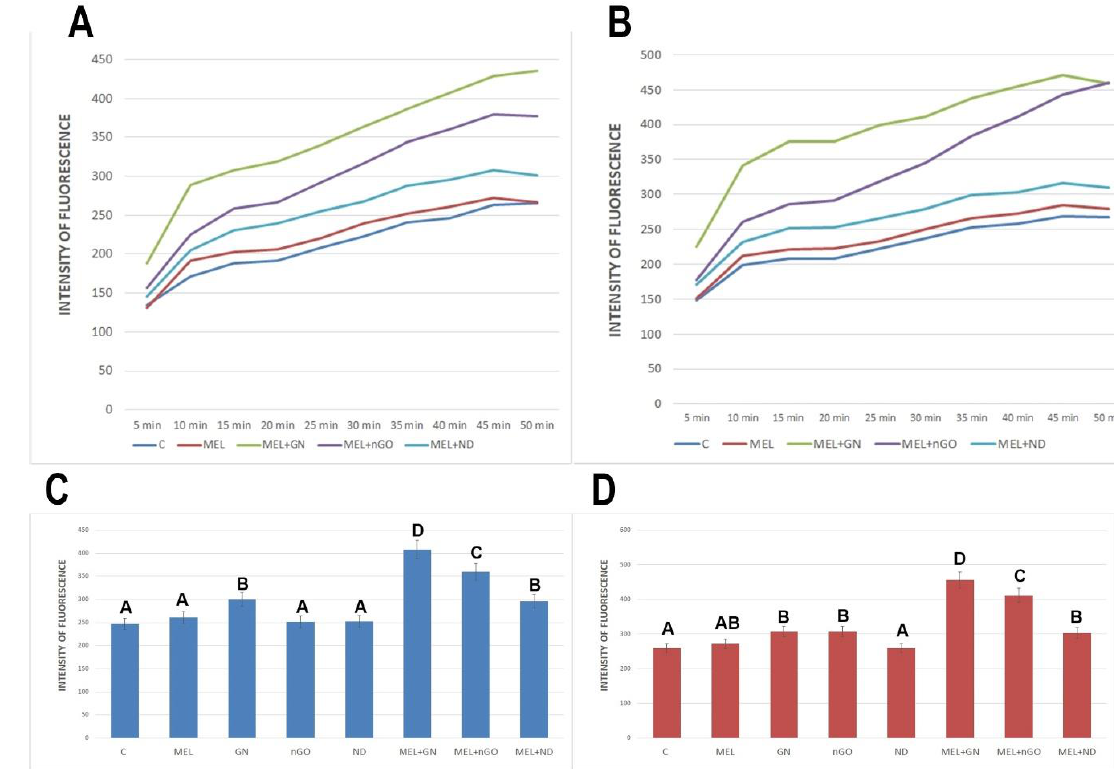
Figure 7. Changes in the level of intracellular reactive oxygen species in MCF-7 and MDA-MB-231 cells after treatment with melittin complexes with nanoparticles, melittin and nanoparticles alone. A,B -Changes in ROS level in time: ( A )—MCF-7 cell line; ( B )—MDA-MB-231 cell line. ( C ),( D